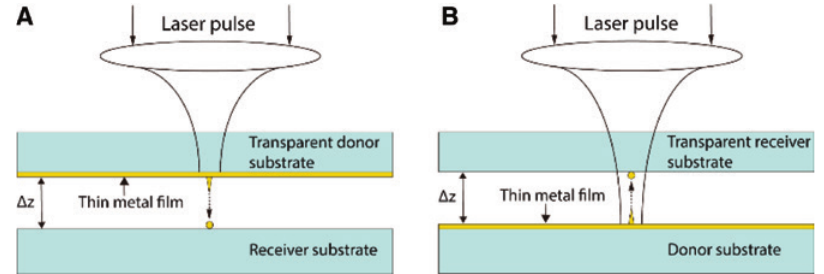
Figure 3: Schematic view of arrangements for the so-called (A) laser-induced forward transfer (LIFT) and (B) laser-induced backward transfer (LIBT). In LIFT mode the laser irradiates the metal film through the transparent donor substrate while in LIBT mode the laser irradiates the thin film through the receiver substrate. Adapted and with permission from Ref.